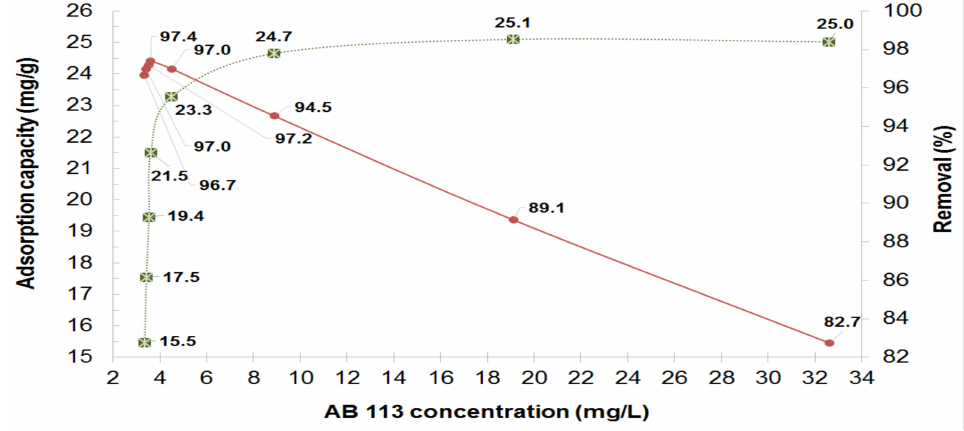
Figure 4. Effect of AB 113 initial concentration on the removal (%) and the adsorption capacity of XAD7HP